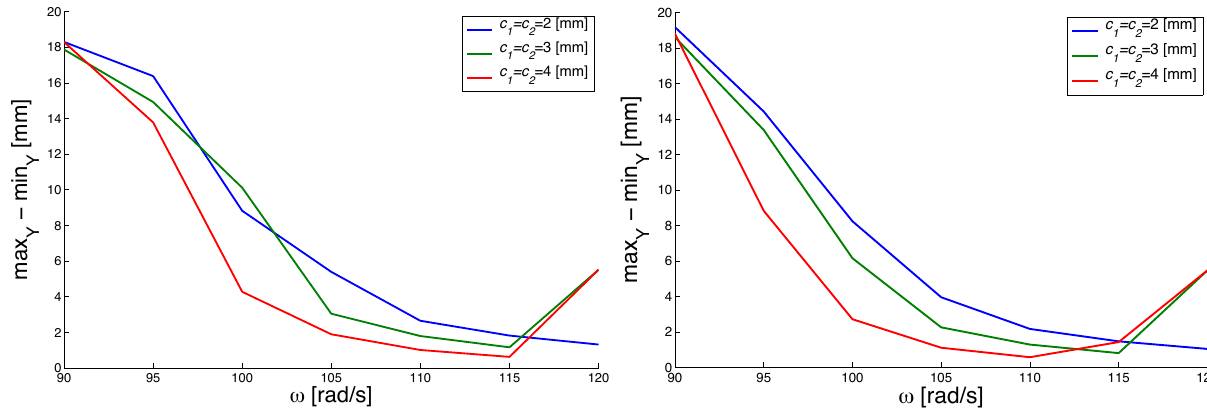
Fig. 8 Peak-to-peak vibrations amplitudes of the rotor frame dependent on the excitation frequency for clearances c 1 = c 2 from 2 mm to 4 mm where (left) corresponds to m t = 22 kg and (right) corresponds to m t = 25 kg. In all these cases impacts occur.